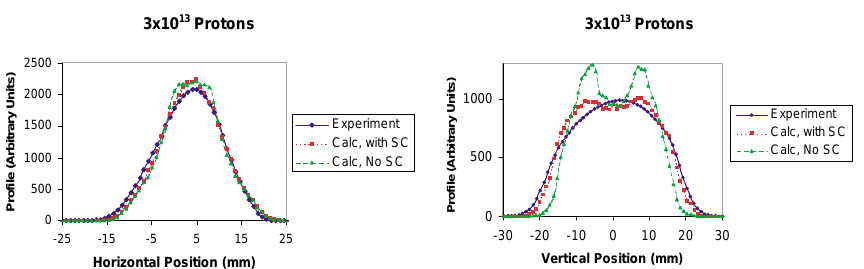
FIG. 3. (Color) The effect of the space charge force on the calculated beam profiles, for the case using a painted vertical bump during injection and at the highest intensity.